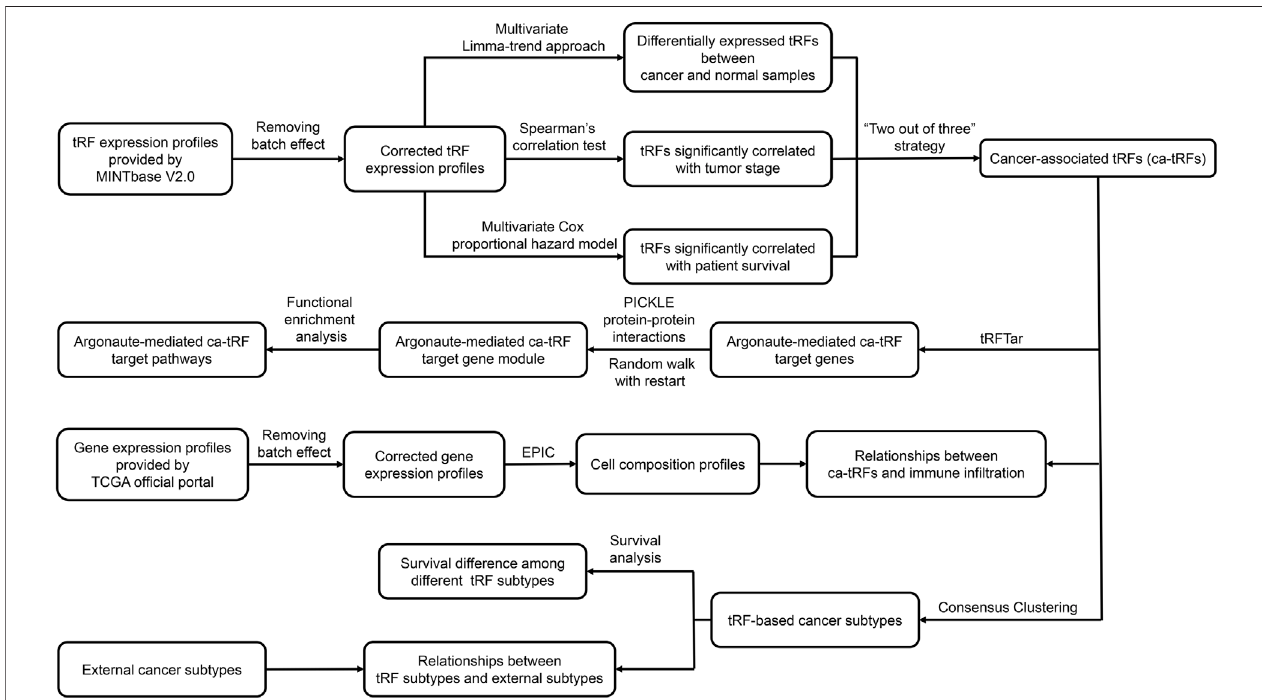
FIGURE 1 | Analysis pipeline of the work. In this work, based on the tRF expression pro fi les of TCGA samples provided by MINTbase V2.0, we screened cancer- associated tRFs (ca-tRF) for seven cancer types, including BRCA, HNSC, KIRC, KIRP, LIHC, LUSC, and THCA, by considering three candidate tRF sets including the differentially expressed tRFs between cancer samples and normal samples (cde-tRF), the tRFs signi fi cantly correlated with clinical tumor stage (tsca-tRF) and the tRFs signi fi cantlycorrelatedwithpatientsurvival(psca-tRF).Theca-tRFswerefurtherdeterminedbya “ twooutofthreestrategy, ” whichmeansaca-tRF mustbelongto at least two of the total three sets. Then we performed extensive analyses on the screened ca-tRF set. First, by incorporating the dataset of Argonaute-mediated tRF- target gene interactions from the tRFTar database, we located the ca-tRF target genes and further the target gene modules. Then by performing functional enrichment analysis on the gene modules, the carcinogenic and cancer-promoting roles of ca-tRFs were inferred. Subsequently, we deconvoluted the gene pro fi les of TCGA samples via the EPIC tool to measure the immune in fi ltration degree and further demonstrated the immuno-regulatory roles of ca-tRFs. Next, by means of consensus clustering, we identi fi ed several ca-tRF-based cancer subtypes. Survival curves exhibit signi fi cant survival differences among these subtypes, indicating the prognostic values of ca-tRFs. Finally, to reveal the dependence or independence of ca-tRFs on the other molecular signatures, the relations between ca-tRF subtypes and various existing external subtypes were